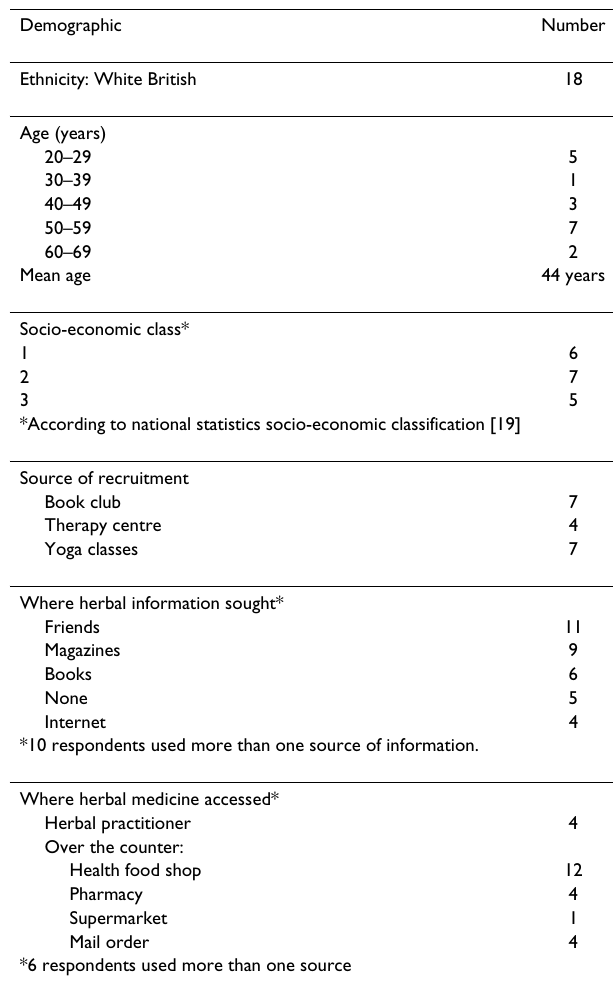
Table 1: Demographic Characteristics of Women Interviewed ( n =